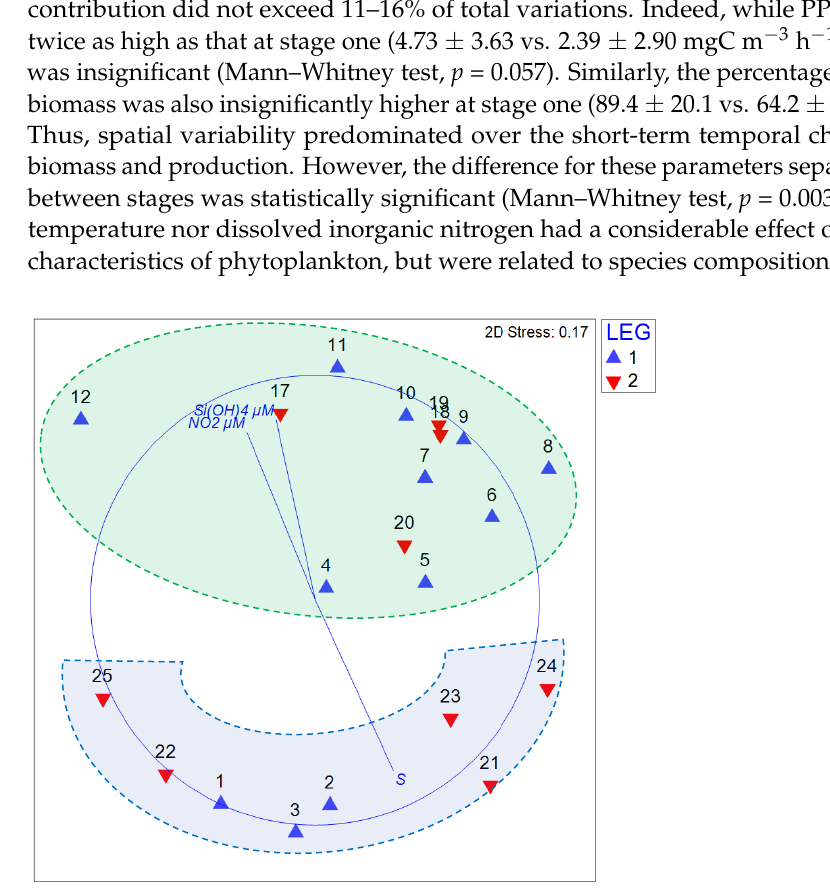
Figure 8. n MDS ordination plot of stations (numbers). Shaded areas mark the estuarine (upward) and marine (downward) groups of stations. Vectors indicate the environmental variables with the highest correlation with the biotic ordination positions. Table 3. Significance level ( p ) and proportion of explained variation (% Var) for predictor included in the final best-fit model. Significant values are highlighted in